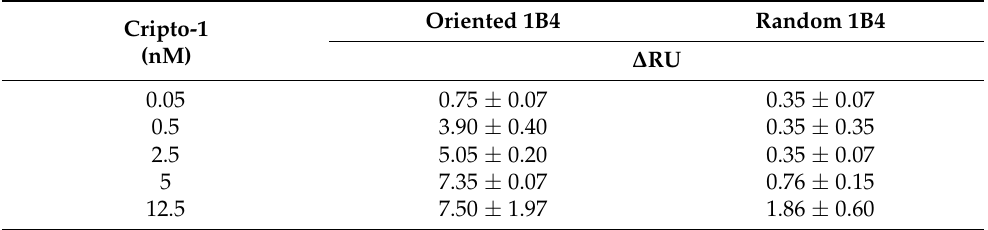
Figure 5. Sensorgrams related to the binding of Cripto-1 at different concentrations (0.05–0.5–2.5–5– 12.5 nM) to oriented 1B4 ( a ) and the same antibody randomly immobilized ( b ). Table 1. RU measurements of the binding of Cripto-1 to oriented 1B4 and to randomly immobilized 1B4 on GC biosensors. Each point is the mean of three different